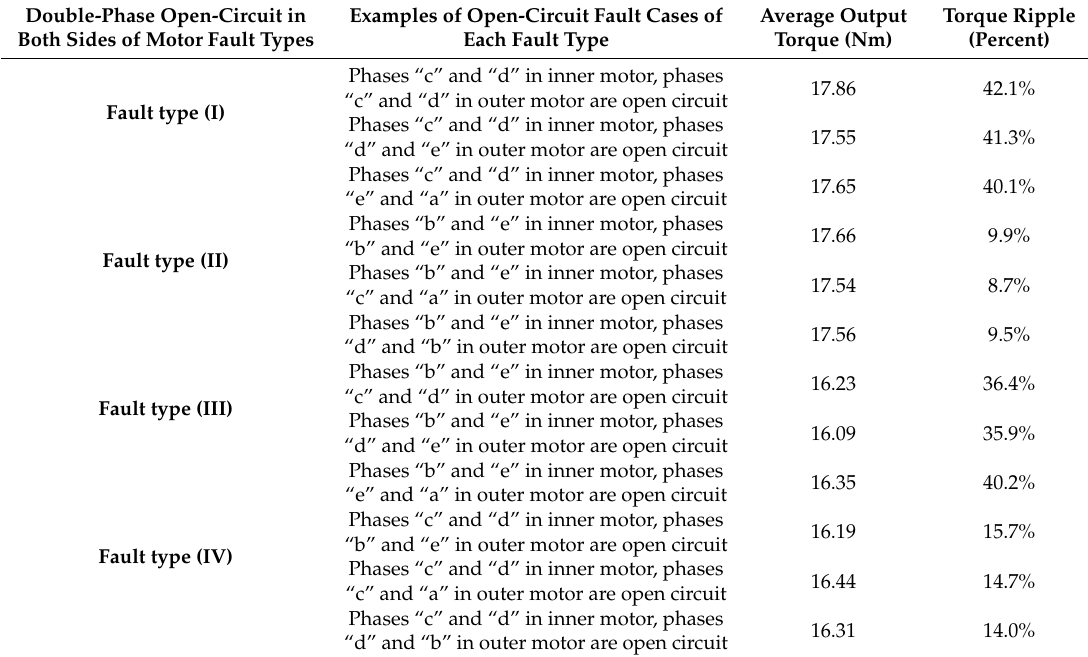
Figure 27. The electromagnetic torque obtained by FEA under double-phase open-circuit in both sides of motor fault condition ( a ) fault type I; ( b ) fault type II; ( c ) fault type III; ( d ) fault type IV. Table 13. The details of electromagnetic torque under double phase open circuit in both sides of the motor fault